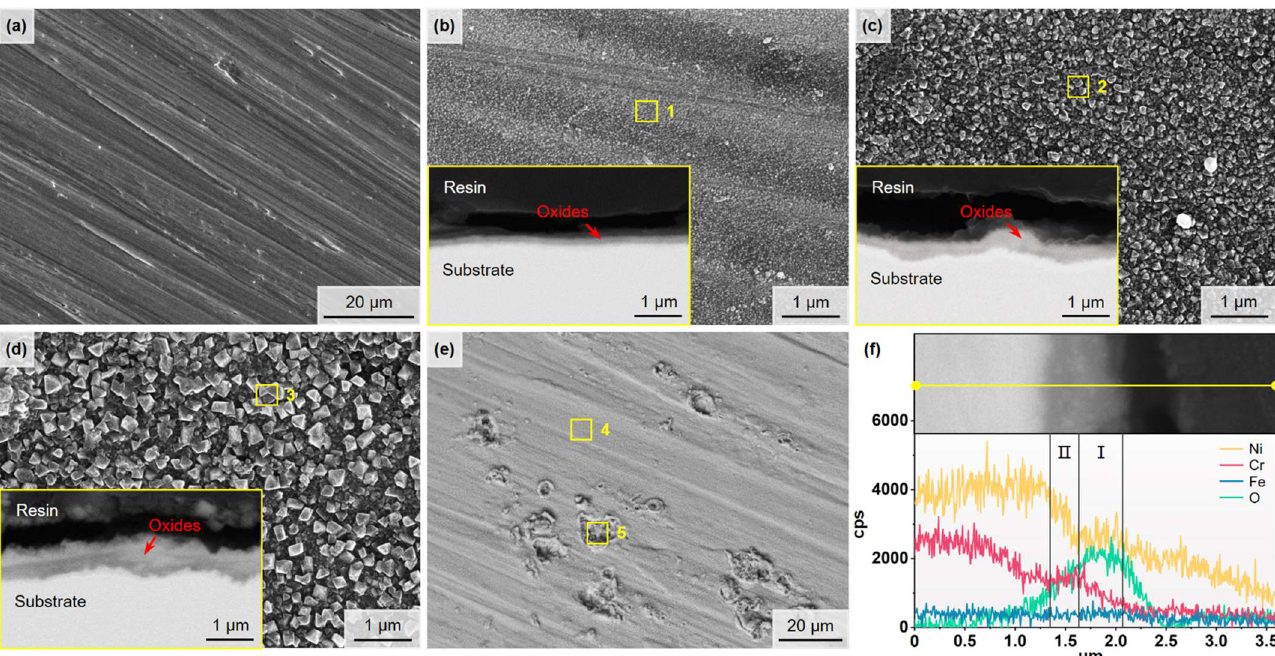
Figure 8. Surface and cross-sectional micrographs of IN625 alloy exposed to Solar Salt at 565 °C for ( a ) 0 day, ( b ) 1 day, ( c ) 7 days, and ( d ) 15 days. Panel ( e ) shows a surface micrograph for the sample immersed for 15 days at low magnification. Panel ( f ) presents a magnified view of the cross-section and corresponding EDS line scanning for the sample immersed for 15 days. NB: The inserts in panels ( b – d ) show the cross-sectional view for the corresponding sample. Table 4. EDS elemental analysis of regions marked in Figure 6 for P91 alloy (in wt.%).